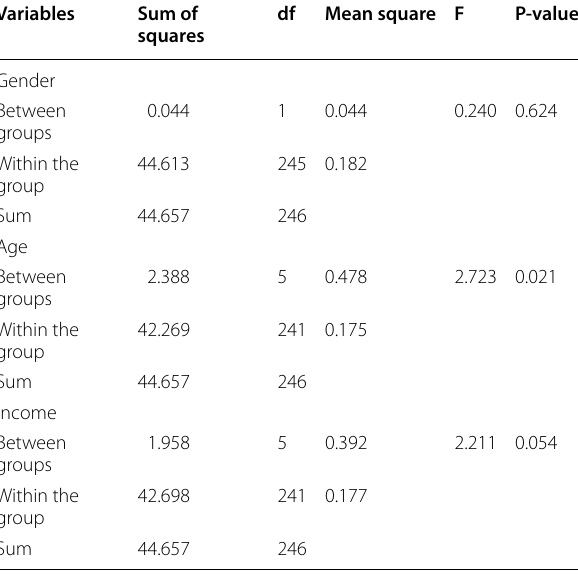
Table 3 One-way ANOVA CSR by gender, age and